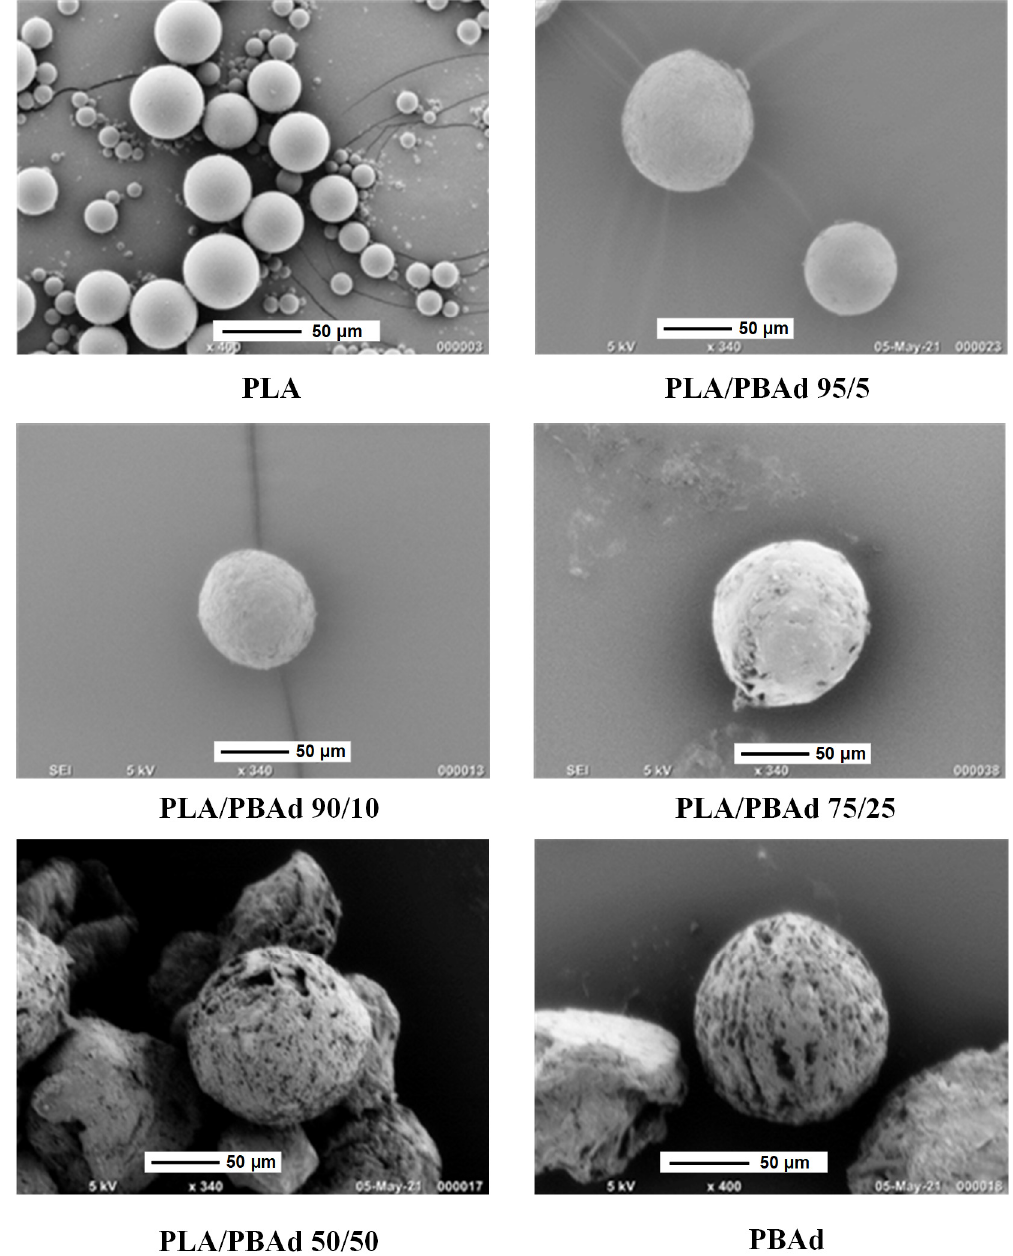
Figure 9. SEM images of the polyester erosion process after 30 days of